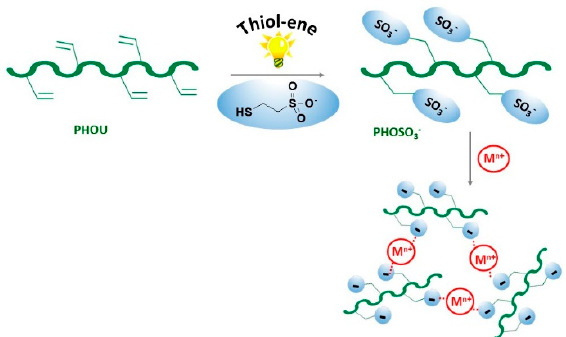
Figure 1. Gelation process of PHOSO 3 − induced by cationic species as Ca 2+ , Mg 2+ , Ba 2+ , and gallic and tannic acid derivatives.